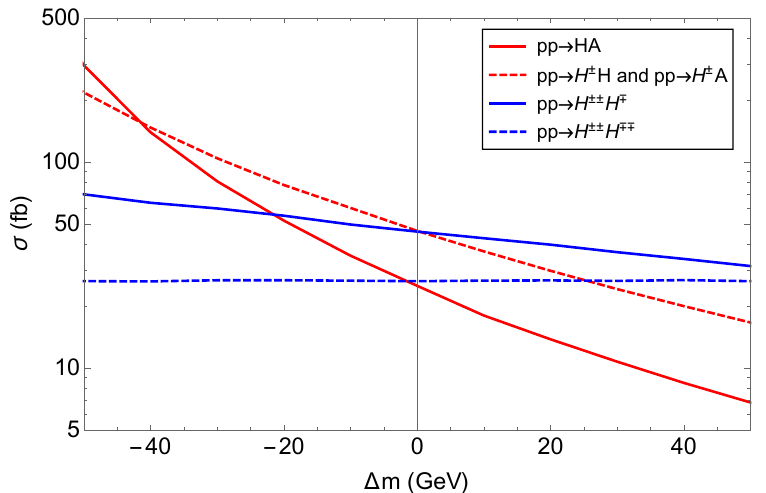
Figure 3 . The production cross sections for each production channel for m function of the mass difference ∆ m . In this figure we assume m 2